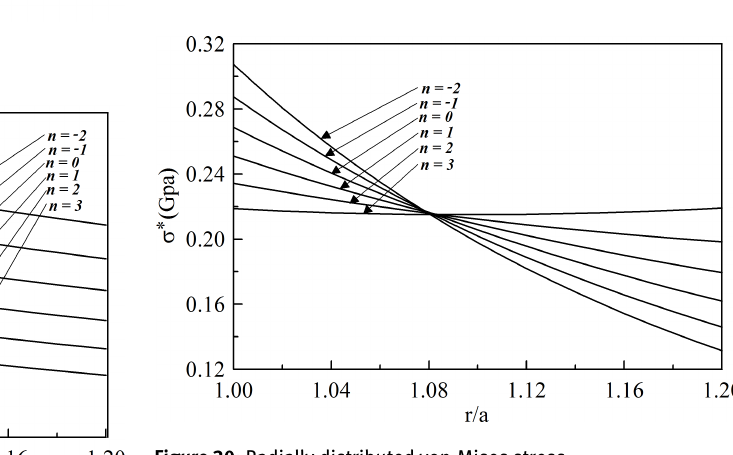
Figure 30: Radially distributed von-Mises